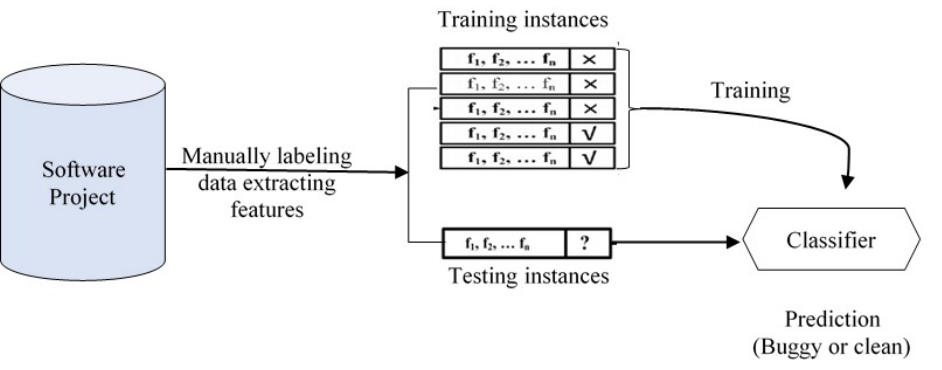
Figure 2. Traditional producer of the software defect prediction (SDP) in abstract